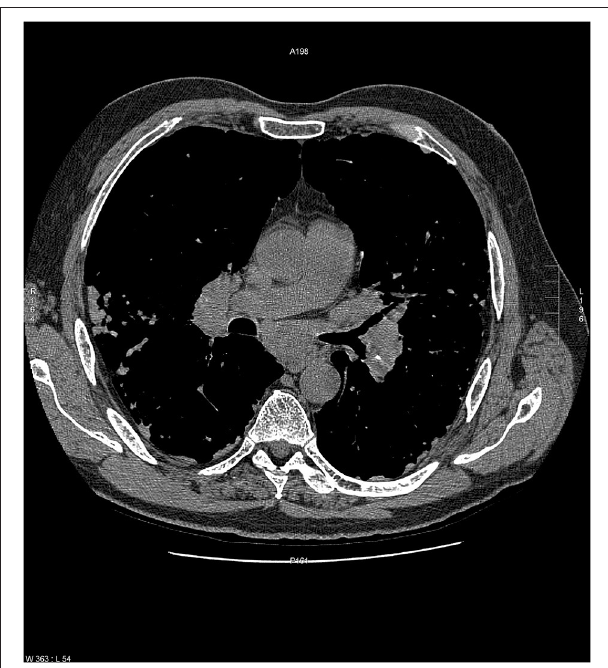
FIGURE 6 | Chest radiograph of a patient with chronic beryllium disease showing imaging features typical of pulmonary sarcoidosis including bilateral hilar adenopathy with some calcium in lymph nodes. Reproduced with permission from Judson (52).